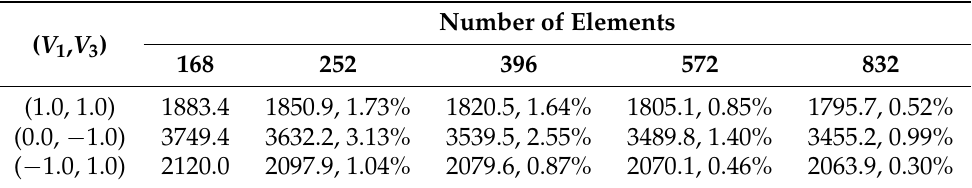
Table 2. Convergence analysis for the fundamental frequency. The frequency values are in Hz. Starting with the second-lowest number of elements, the percentage differences with respect to the previous values are given next to the frequency values followed by commas.